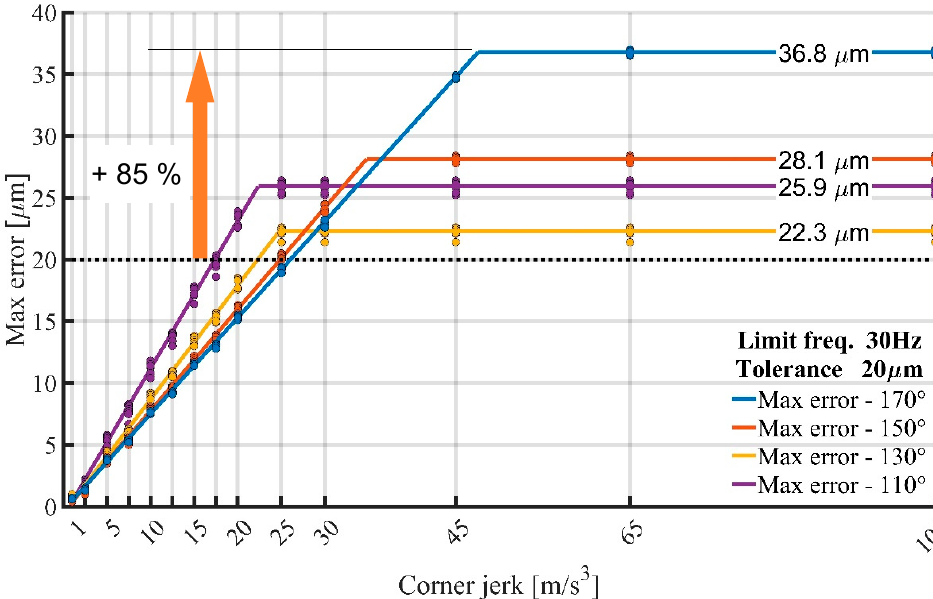
Figure 12. Dependence of maximum error on corner jerk for contour tolerance of 20 μm (horizontal dotted line) and limit frequency of 30 Hz. The results for individual angle sizes are distinguished by their color. The regression models are shown as full lines. The test result data are displayed as colored dots.